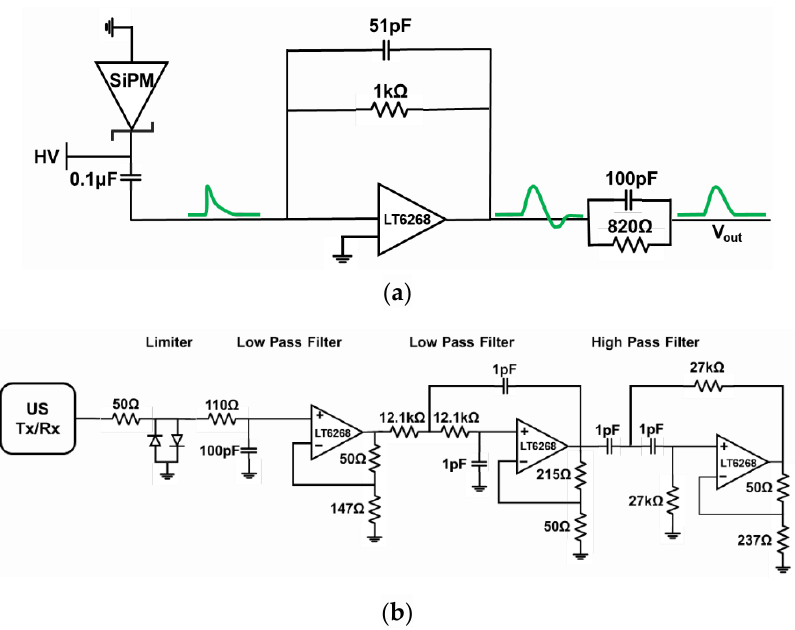
Figure 3. Schematic of an analog front end. ( a ) Charge-sensitive amplifier (CSA) front-end circuit for